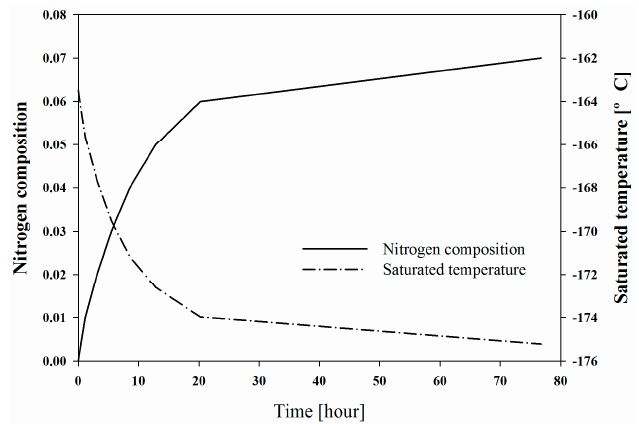
Figure 16. Changes in nitrogen composition and temperature required for storage without flash gas venting.